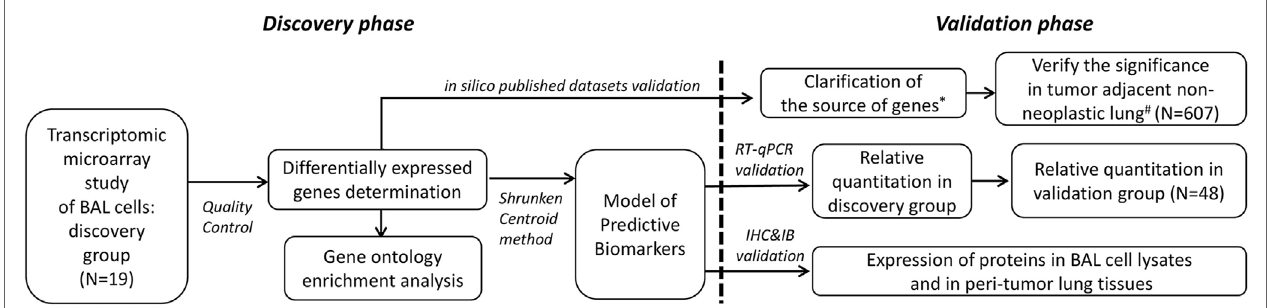
FigUre 1 | Demonstration of the two-phase workflow of the study. *Datasets of Gene Expression Omnibus (GEO) accession: GSE10245, GSE32474, GSE1133, GSE72642, and GSE8823 were used. # Datasets of GEO accession: GSE1643, GSE16538, GSE24206, GSE18995, GSE19188, GSE19804, GSE40791,